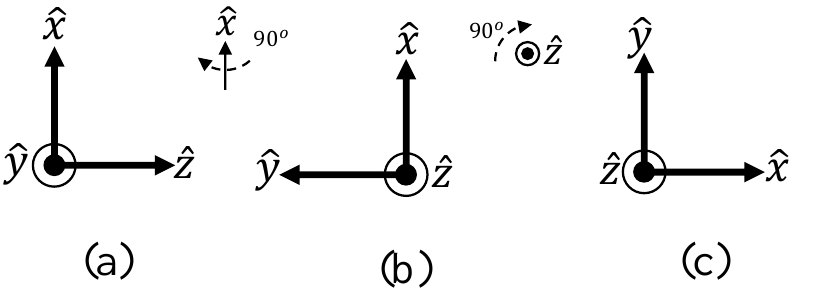
Figure 3. Coordinate grid rotation steps. ( a ) Initial orientation of analytical formulation for 2D TE z . ( b ) Intermediary rotated mapping. ( c ) Final mapped orientation of analytical formulation is identical to the FDTD formulation for 2D TM z